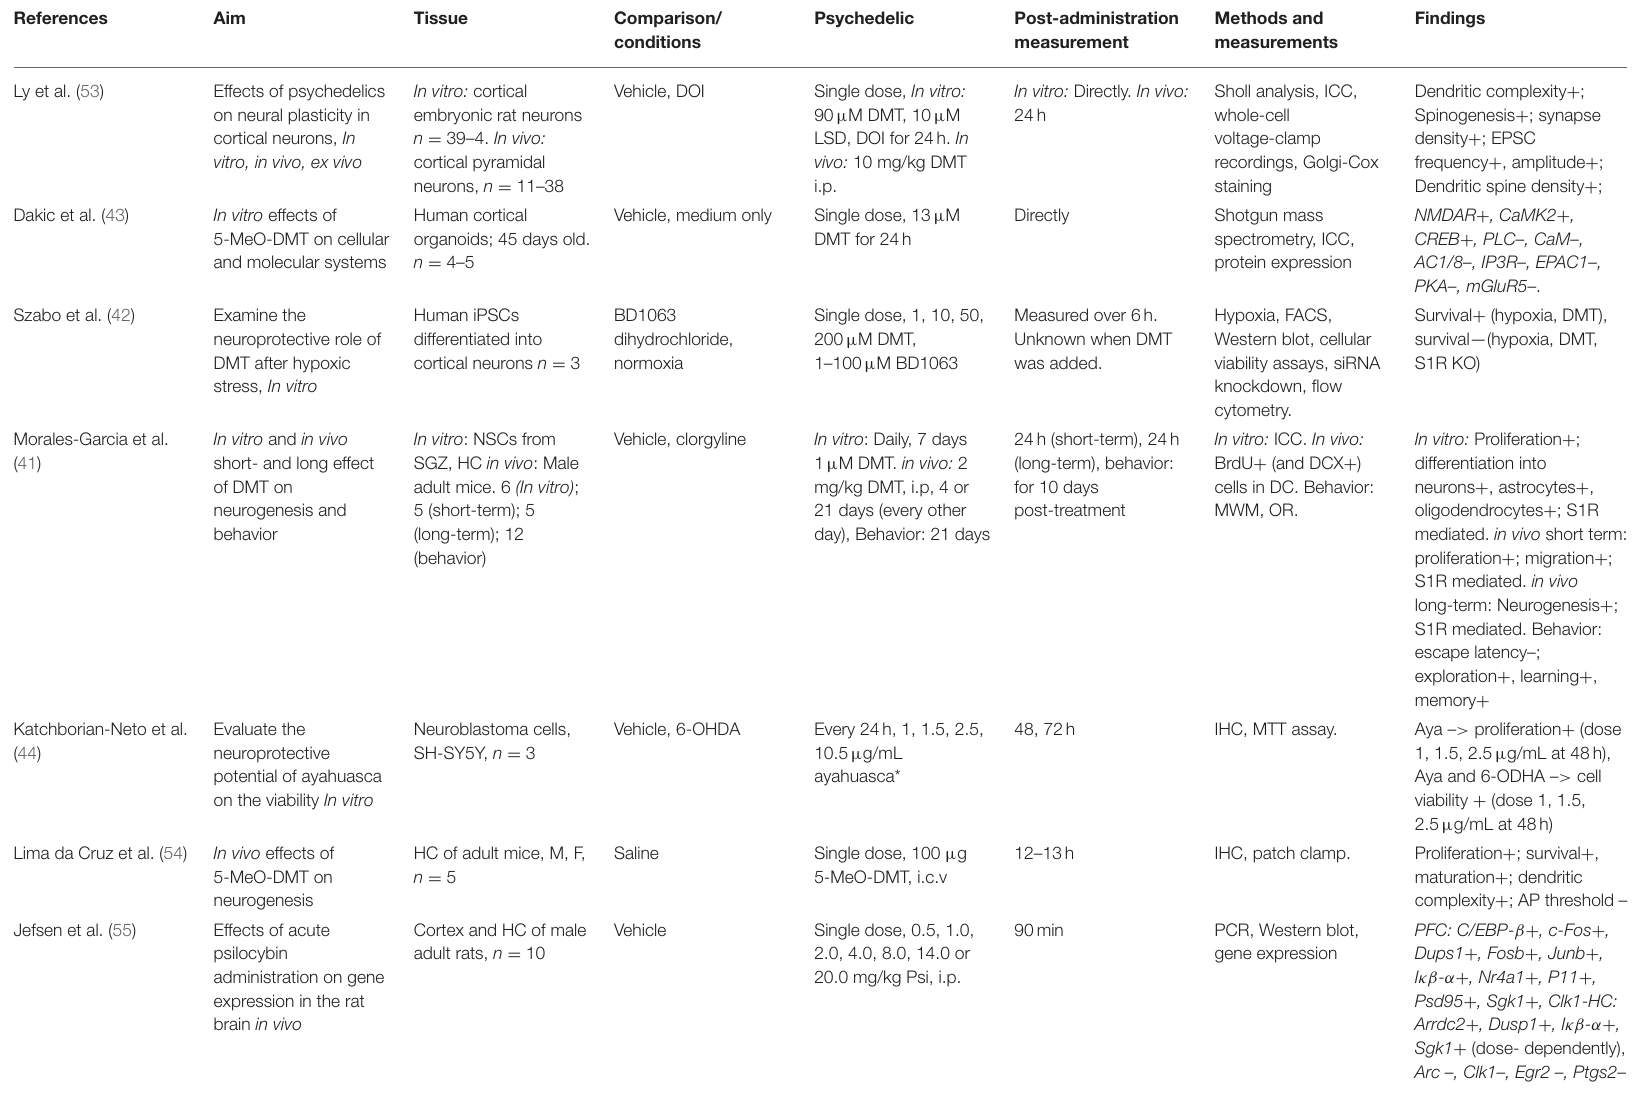
TABLE 1 | Preclinical studies investigating psychedelics’ effects on molecular and (sub)cellular